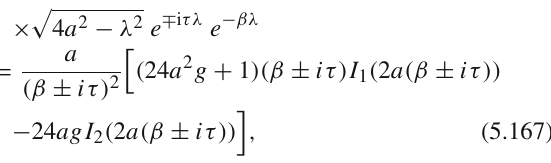
Fig. 25 Eigen value distribution curve of density function for quartic potential for different parameter values. Here we fix a =